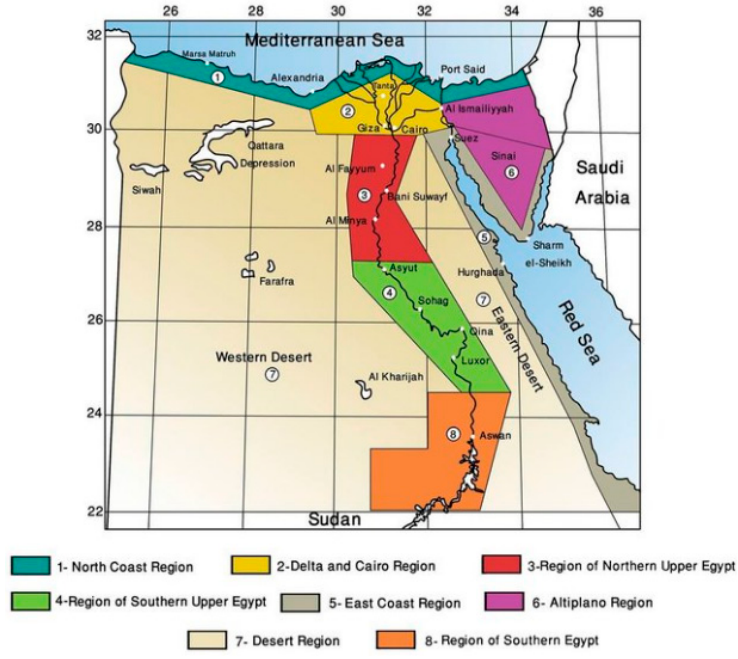
Figure 1. Egypt weather regions according to the Housing and Building Research Center (HBRC) [9].